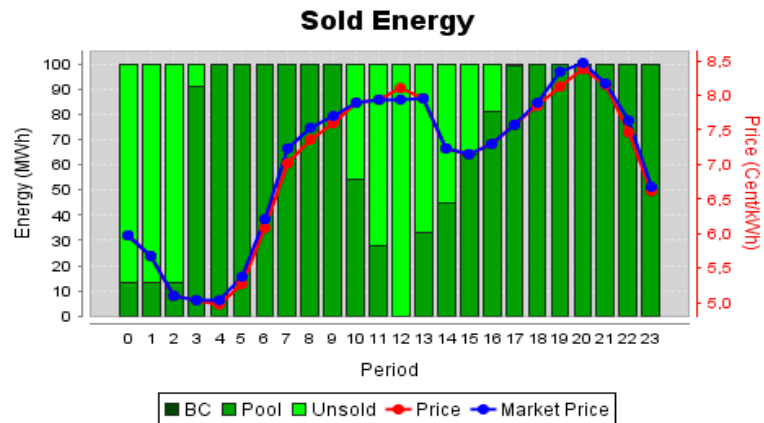
Figure 10. Energy sold on the market considering the results of Guarantees of Origin market.